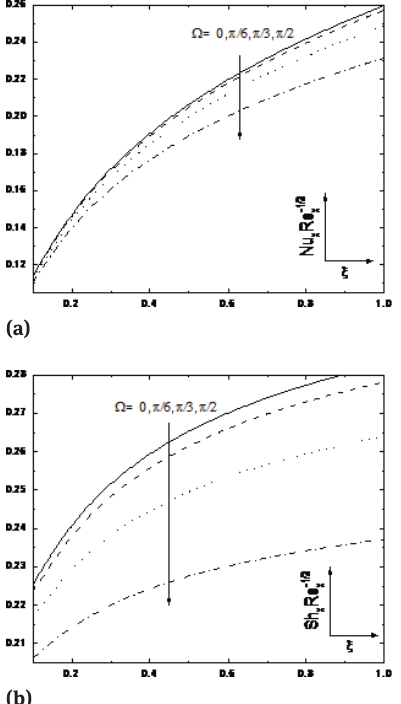
Fig. 8: The effect of Biot number and Mixed convection parameter on (a) local Nusselt number, (b) local Sherwood number for Δ = 0.5, Fs = 0.5, α 1 = 5, α 2 = 5, Ω = π /6.